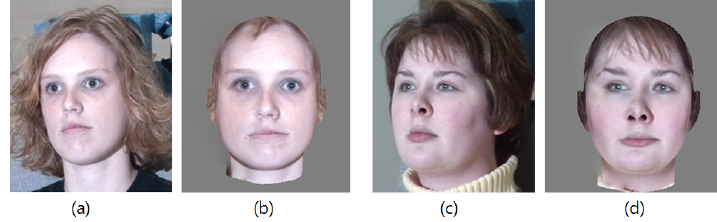
Figure 7. Frontalized faces: ( a , c ) Input images. ( b , d ) Rendered frontalized